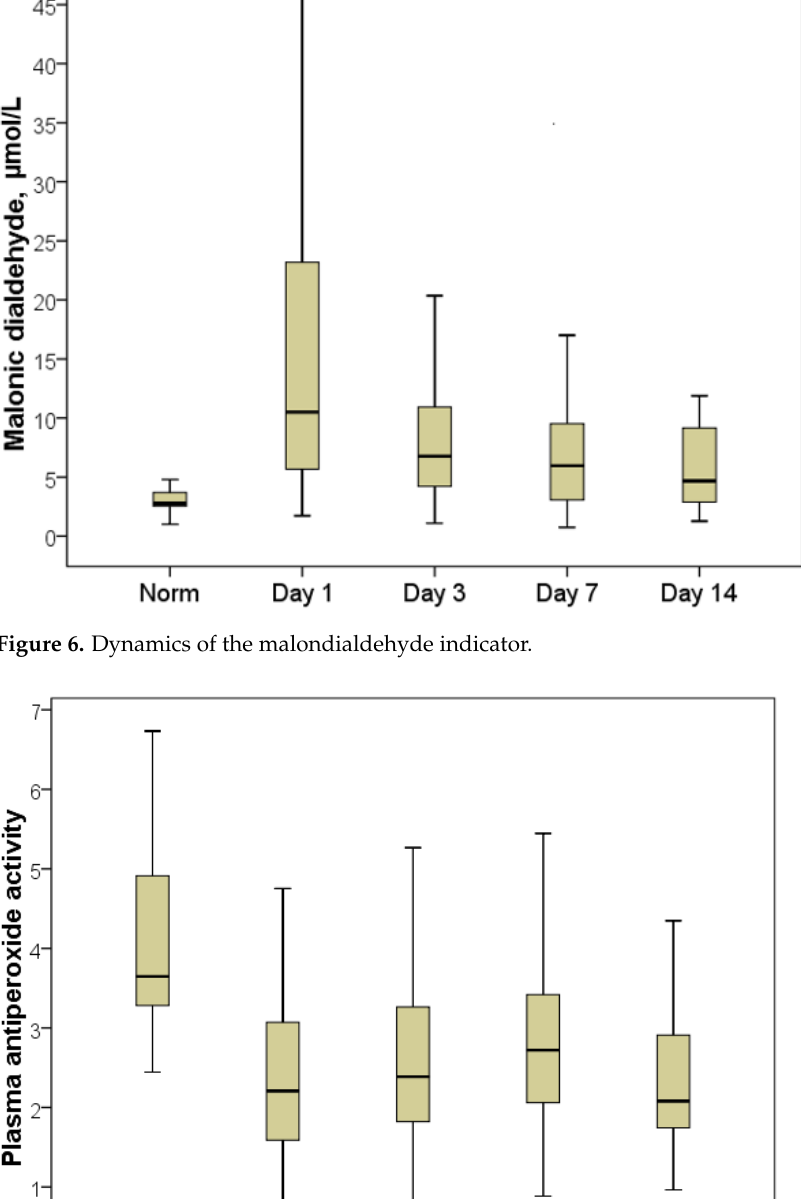
Figure 8. Dynamics of the AC indicator.